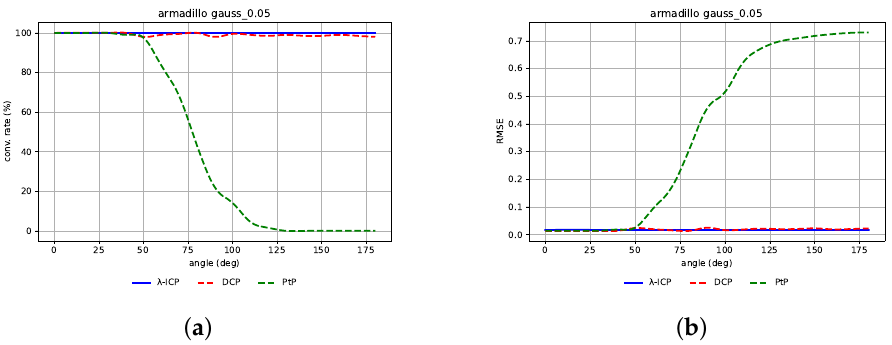
Figure 9. ( a ) Convergence rate of λ -ICP (blue), DCP (red), PtP (green) algorithms for Armadillo with Gaussian noise, σ = 0.05; ( b ) mean RMSE (for transformation matrices) of λ -ICP (blue), DCP (red), PtP (green) algorithms for Armadillo with Gaussian noise, σ =